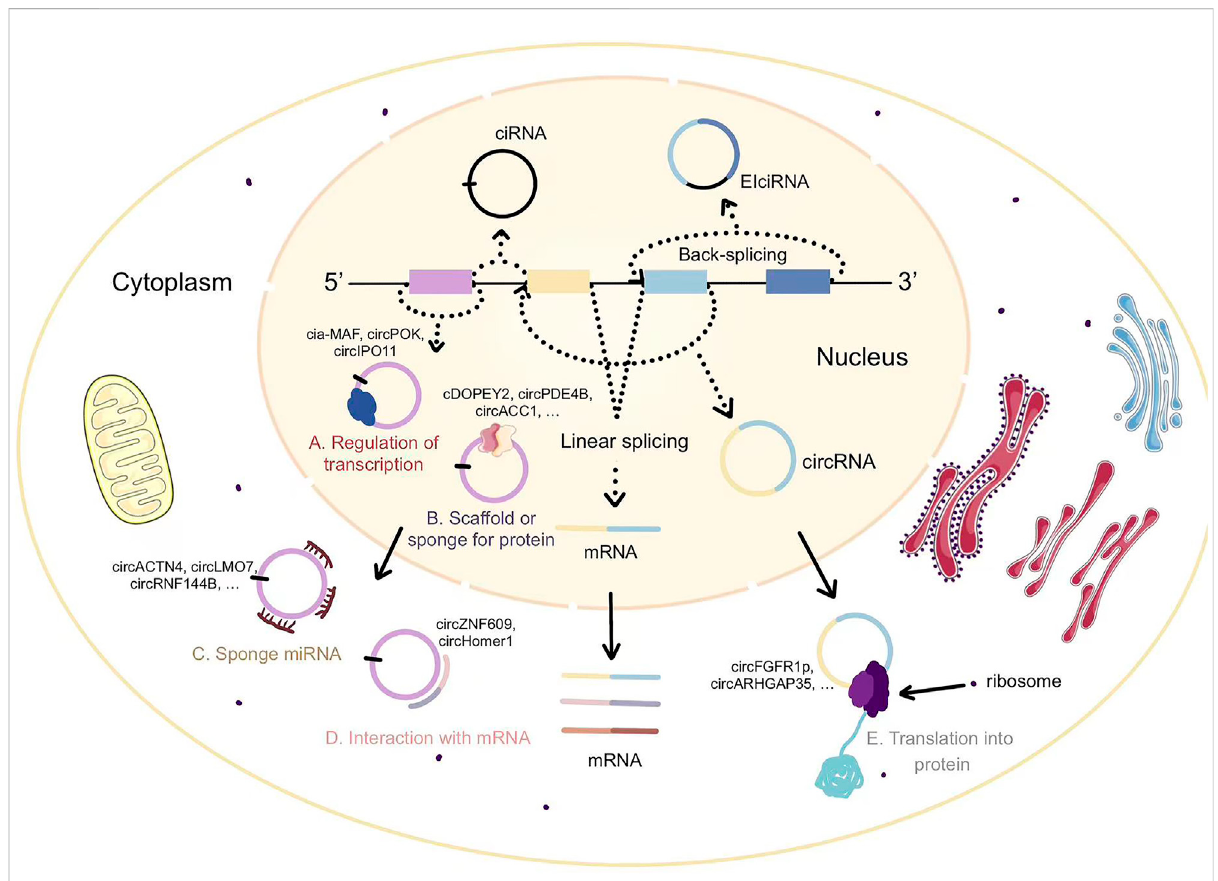
FIGURE 1 The biosynthesis and function of